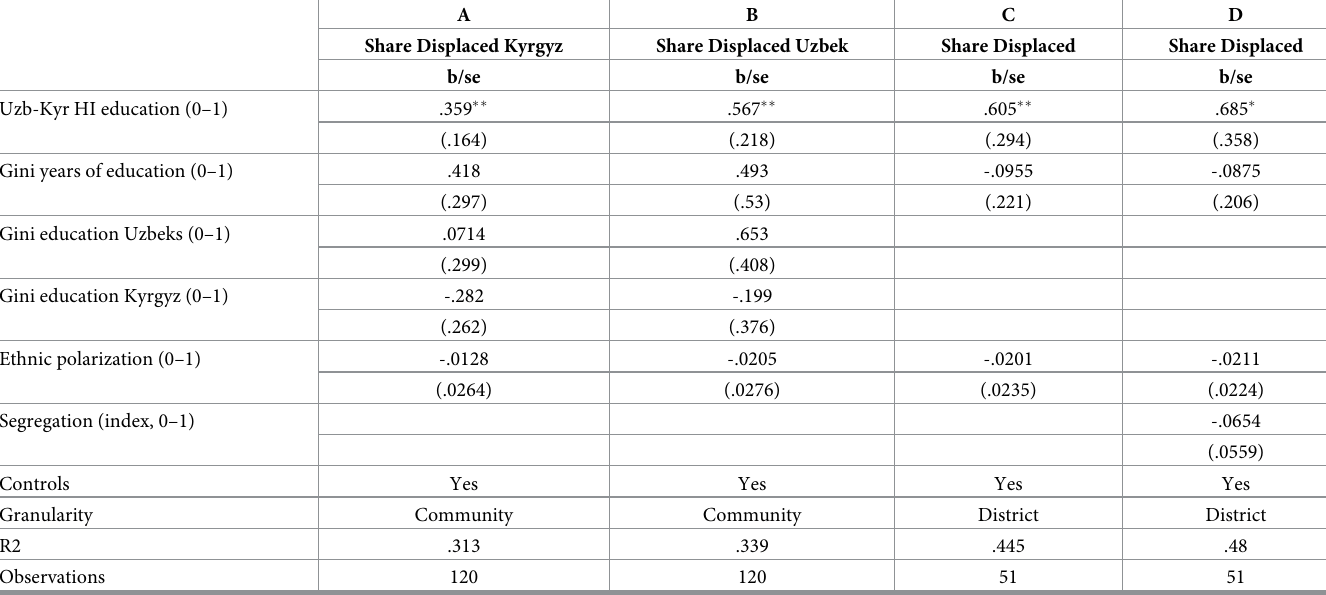
Table 5. Forced displacement in communities and